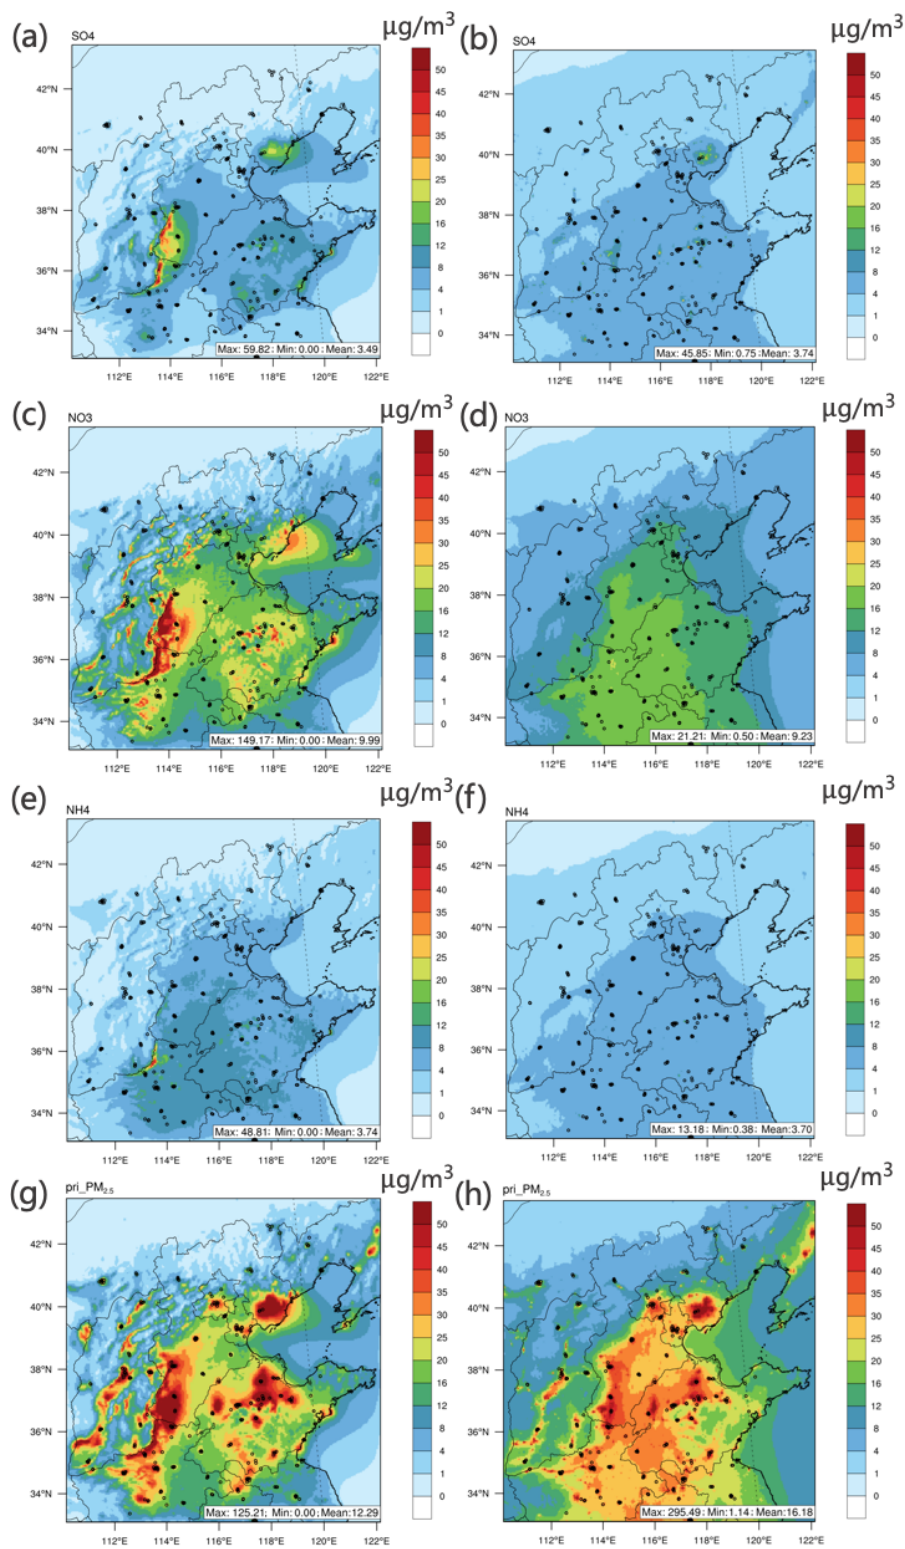
Figure 12. The spatial pattern of PM 2 . 5 compositions simulated in the BTH region at a 4km spatial resolution by the InMAP-China and WRF-CMAQ models. Panels (a) , (c) , (e) and (g) present the respective sulfate, nitrate, ammonium and primary PM 2 . 5 , simulated by InMAP- China. Panels (b) , (d) , (f) and (h) present the corresponding results simulated by WRF-CMAQ. Geosci. Model Dev., 14, 7621–7638,